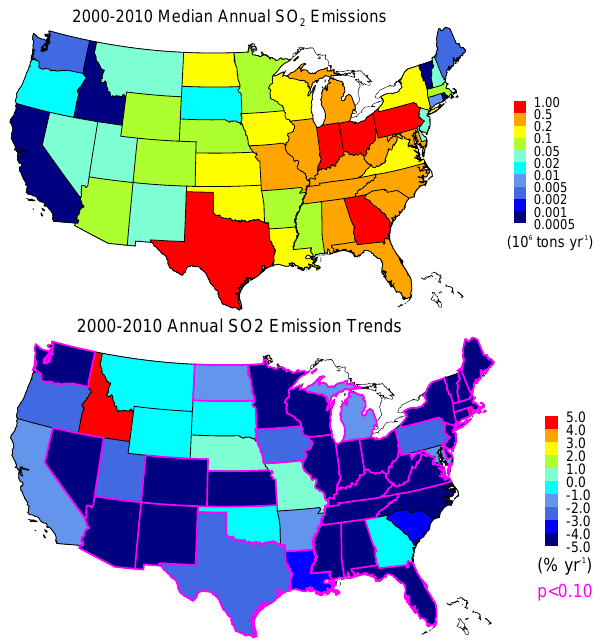
(million t yr − 1 ) (b) 2000–2010 trends (% yr − 1 ) in annual total power plant SO 2 emissions. States with significant trends ( p< 0 . 10) are outlined in